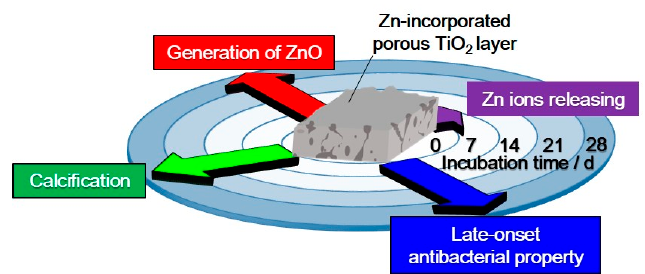
Figure 10. The schematic illustration of time transient e ff ect of Zn in the porous titanium dioxide layer on chemical and biological properties.